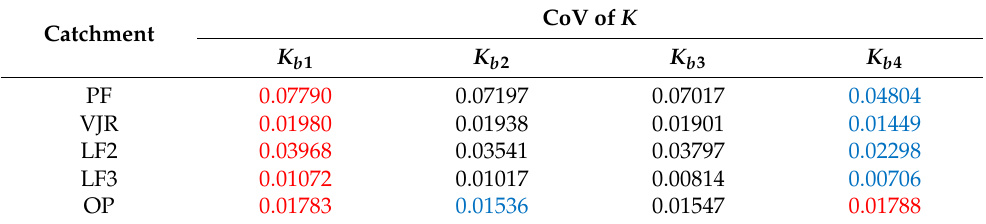
Table 2. Coefficient of Variation (CoV) of K produced by the various K estimators. CoV of K Catchment K b 1 K b 2 K b 3 K b 4 PF 0.07790 LF2 0.03968 LF3 OP 0.01783 0.01536 0.01547